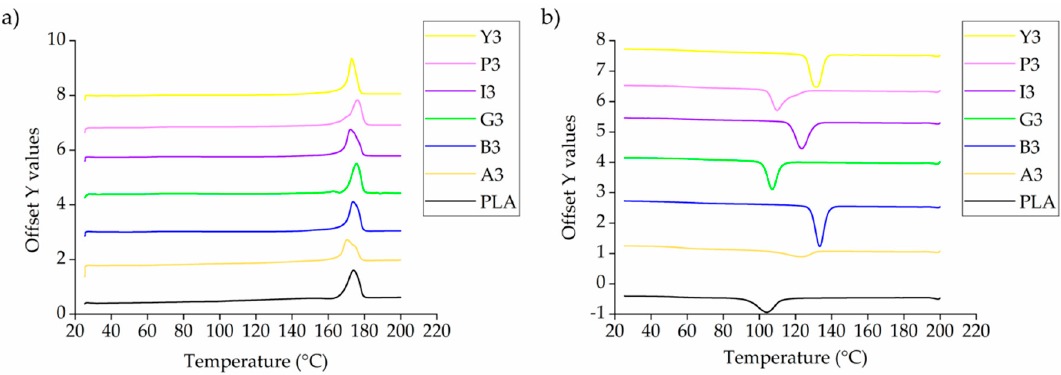
Figure A2. DSC thermograms of PLA and composites containing 3% (w/w) of each additive during ( a ) the heating phase and ( b ) the cooling phase. The rheogram of PLA and the composites containing 1% (w/w) of each additive are presented in Figure A3.